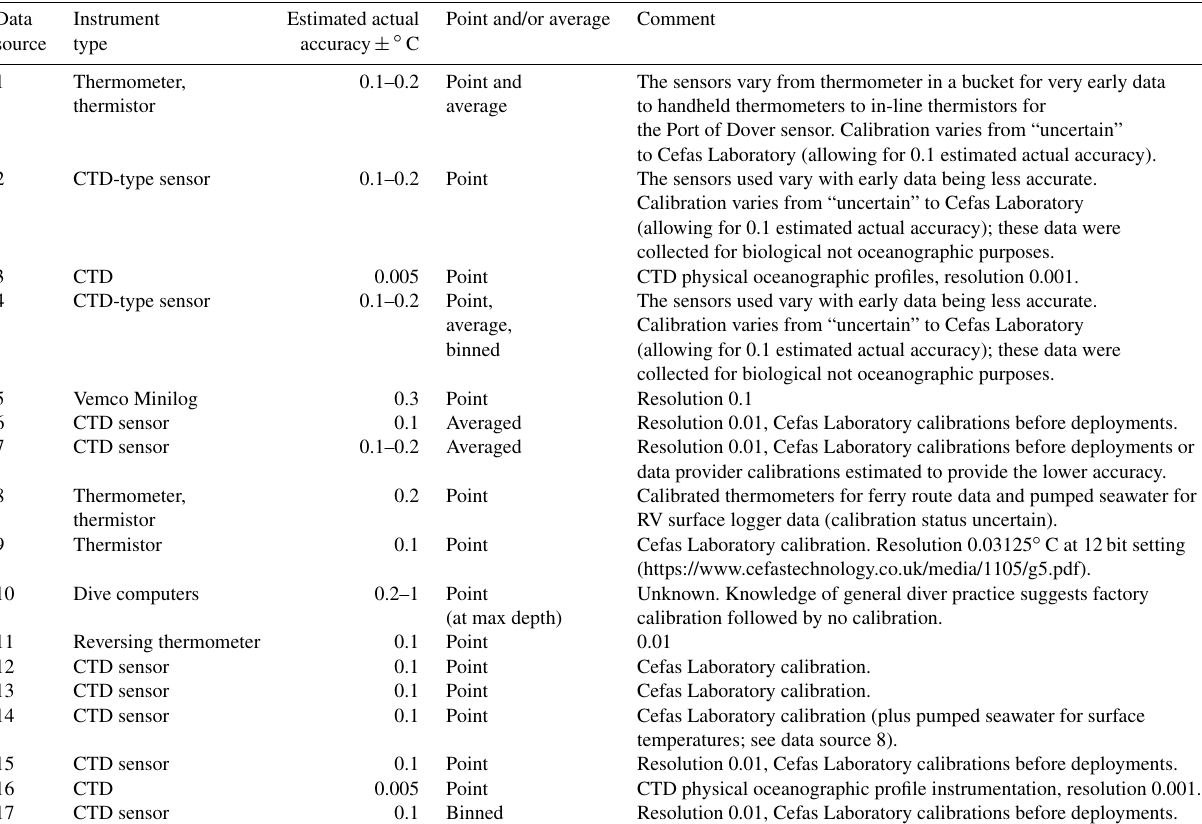
Table 2. Summary of the estimated actual accuracy of seawater temperatures by data source.